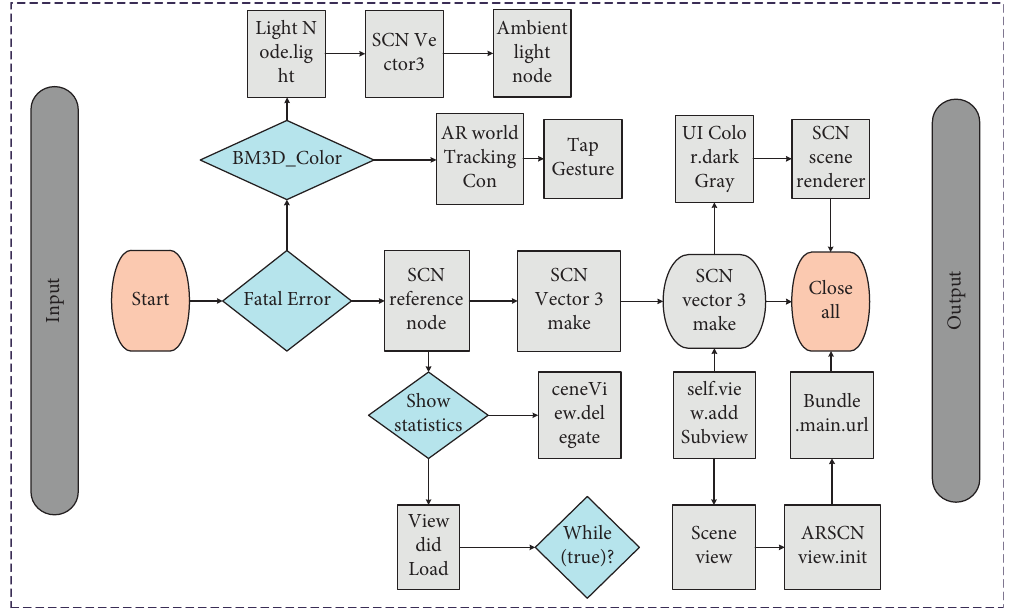
Figure 2: Multivisual animation 3D conversion algorithm based on VR